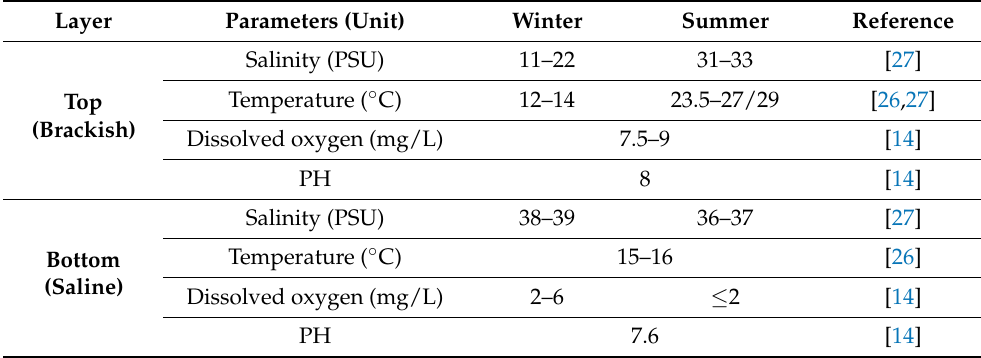
Table 1. Oceanographic parameters of the top brackish and bottom saline water of Amvrakikos Gulf during different seasons (compiled from the